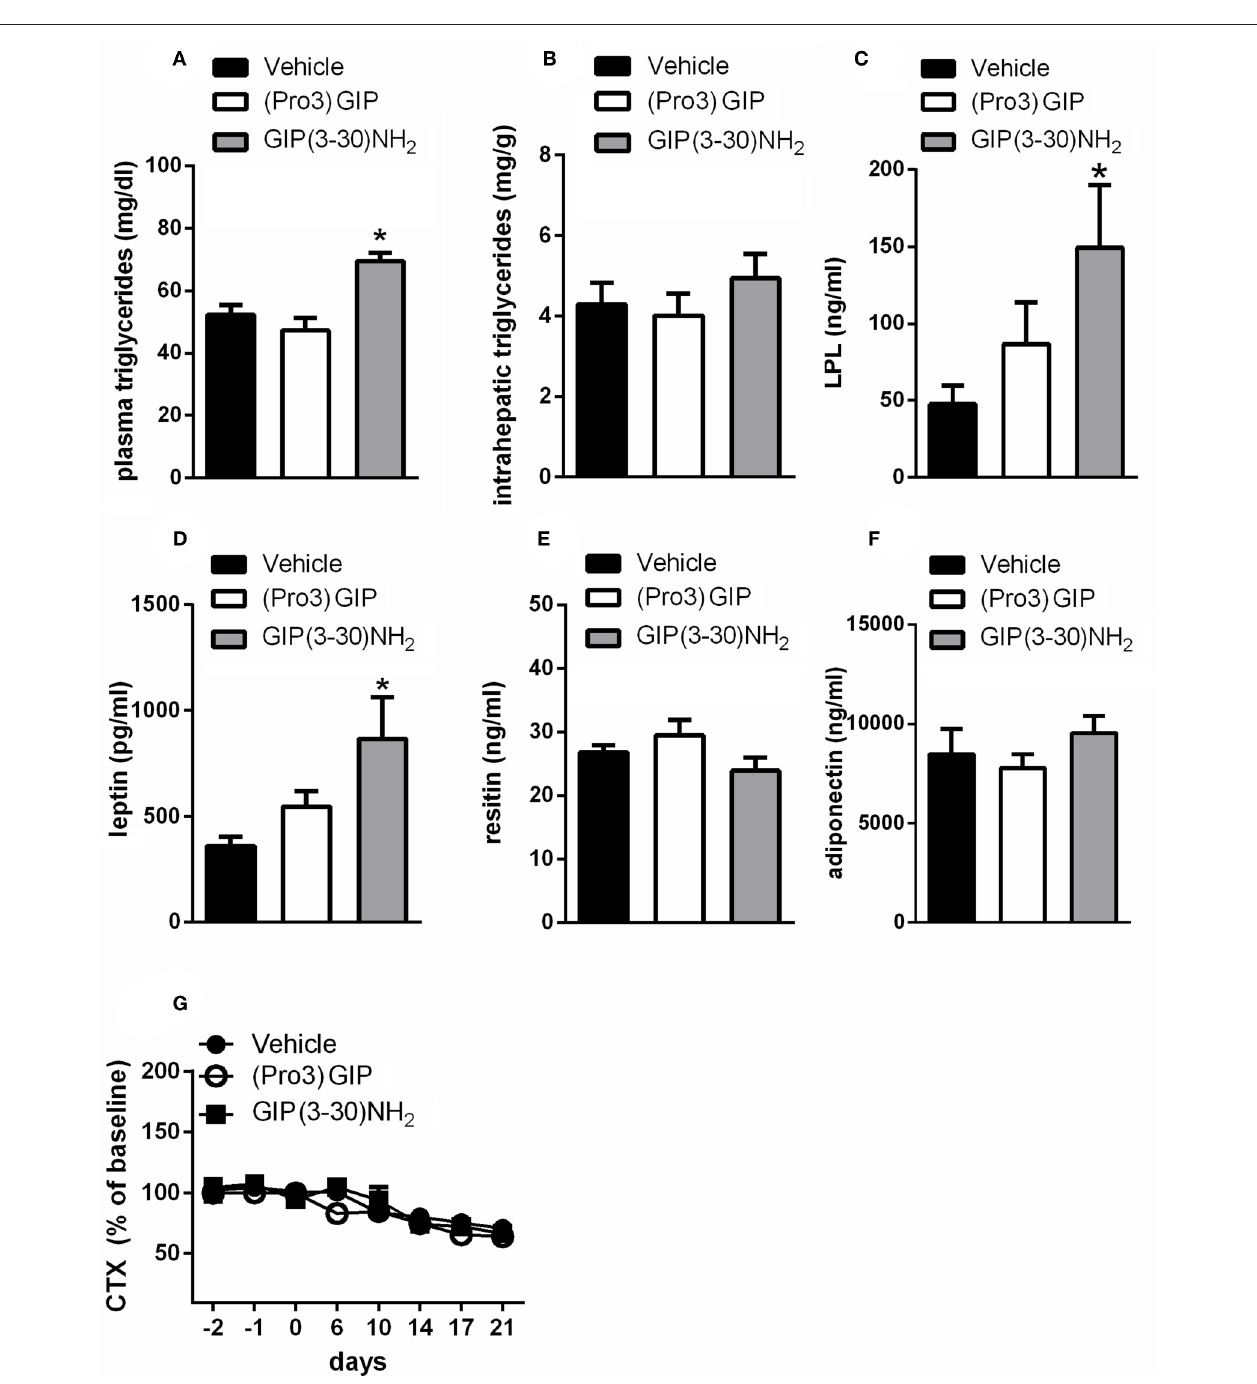
FIGURE 2 | Effects of the subchronic treatment with GIP (3-30)NH 2 (25 nmol/kg b.w.), (Pro3)GIP (25 nmol/kg b.w.) or vehicle treated on triglycerides, adipokines, and CTX: plasma triglycerides (A) , intrahepatic triglycerides (B) , plasma LPL (C) , plasma leptin (D) , plasma resistin (E) , plasma adiponectin (F) , Serum CTX levels (G) . Animals were bled terminally and adipokine levels were determined by ELISA as described under “materials and methods.” CTX values were expressed as percent of the mean of the baseline values (days − 2, − 1, 0) of the individual animal. Data are shown as mean ± SEM, n = 6 per group. * p < 0.05 vs. vehicle treatment.